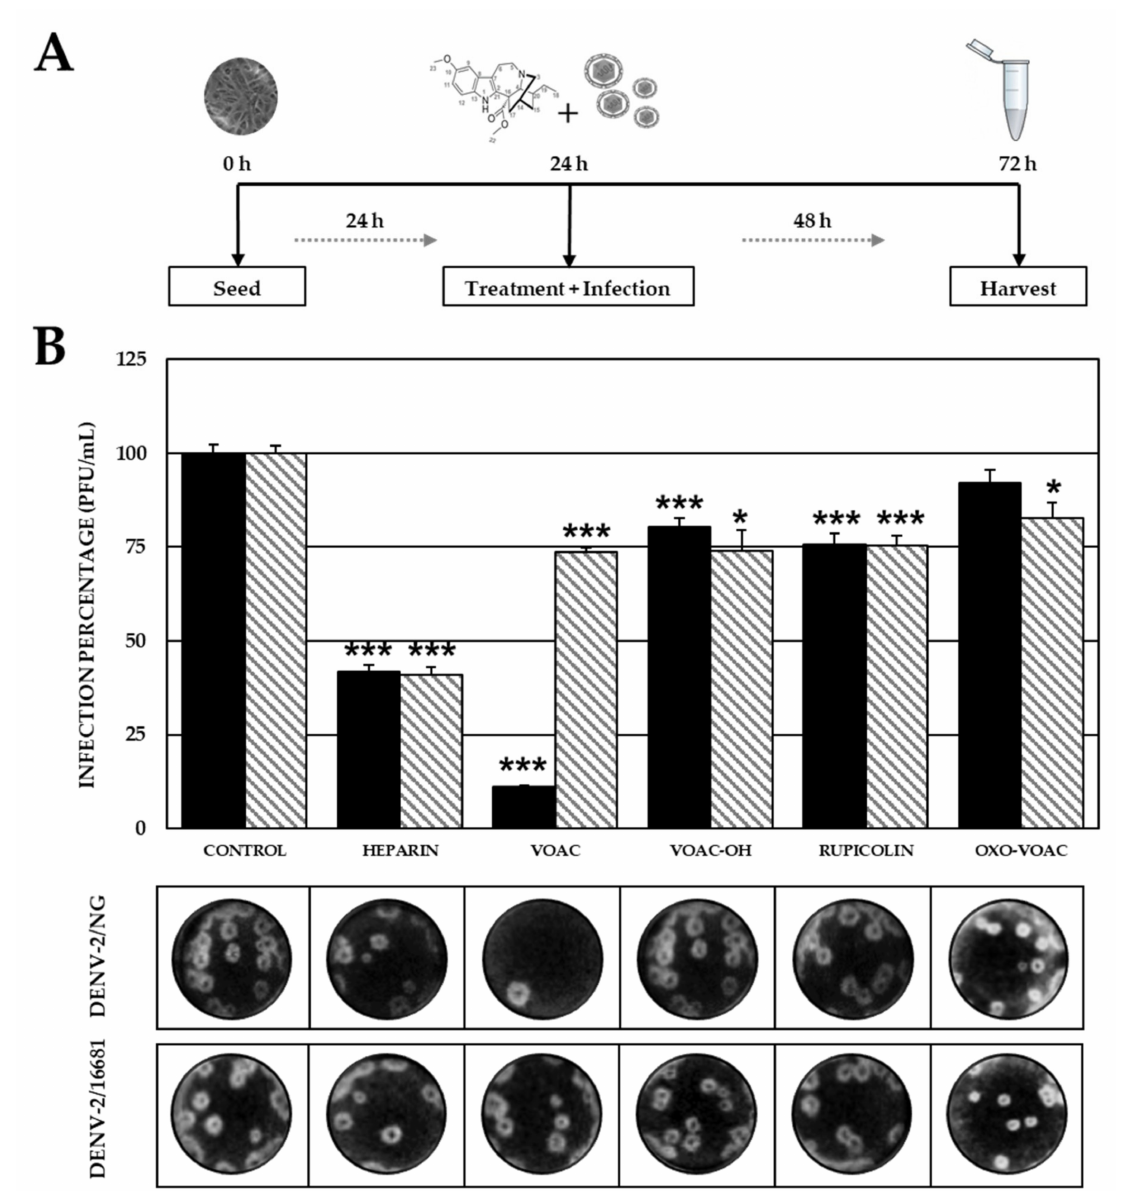
Figure 3. Virucidal effect against DENV-2 strains. ( A ) Schematic representation of the Trans-treatment strategy explained in the Materials and Methods section. ( B ) Infection percentage in each experimental condition. Vero cells were treated and infected at the same time with DENV-2/NG (Dark bars) or DENV-2/16681 (Clear bars). The asterisks indicate statistically significant differences with respect to the control without compound (* p < 0.05 and *** p < 0.001; t -Student) and error bars indicate standard error of the mean; n : 4. Moreover, it shows representative images of plaque formed in each experimental